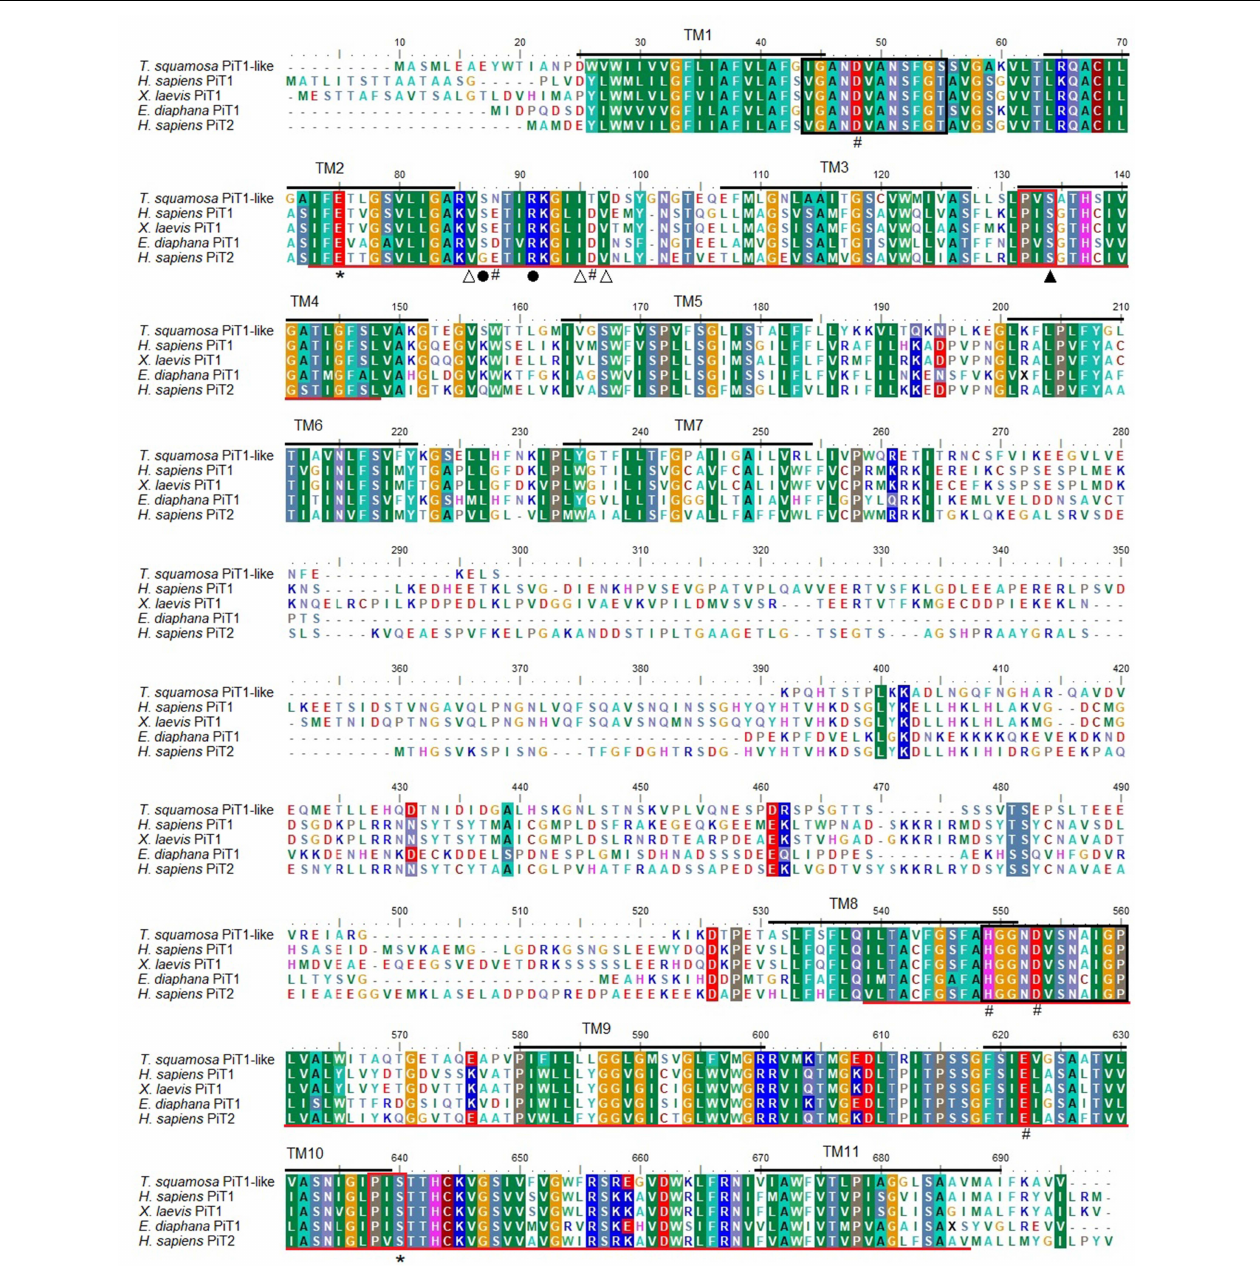
FIGURE 2 | A multiple sequence alignment of the deduced amino acid sequence of sodium-dependent phosphate transporter protein 1-homolog (PiT1-like) obtained from Tridacna squamosa , Homo sapiens PiT1 (NP_005406.3), Xenopus laevis PiT1 (NP_001087494.1), Exaiptasia diaphana PiT1 (XP_020903863.1) and the PiT2 paralog from Homo sapiens (Q08357.1). The 11 transmembrane regions (TMs) predicted using the TOPCONS server have been delineated in black with the region number above. The two ProDom (PD001131) domains are underlined in red. The 12 amino acid-long signature sequence of the PiT family is marked with a black box. The red boxes denote the conserved P-X-S motif at the N and C terminal (where X is a hydrophobic amino acid). Residues identified as critical for P i transport in human PiT1 protein are indicated with asterisks while residues that are important for P i transport in human PiT2 paralog are marked with hash. Residues marked by open triangles constitute part of the substrate binding site(s) whereas the residue marked by a closed triangle binds P i . Residues indicated with closed circles play a role in substrate selectivity and